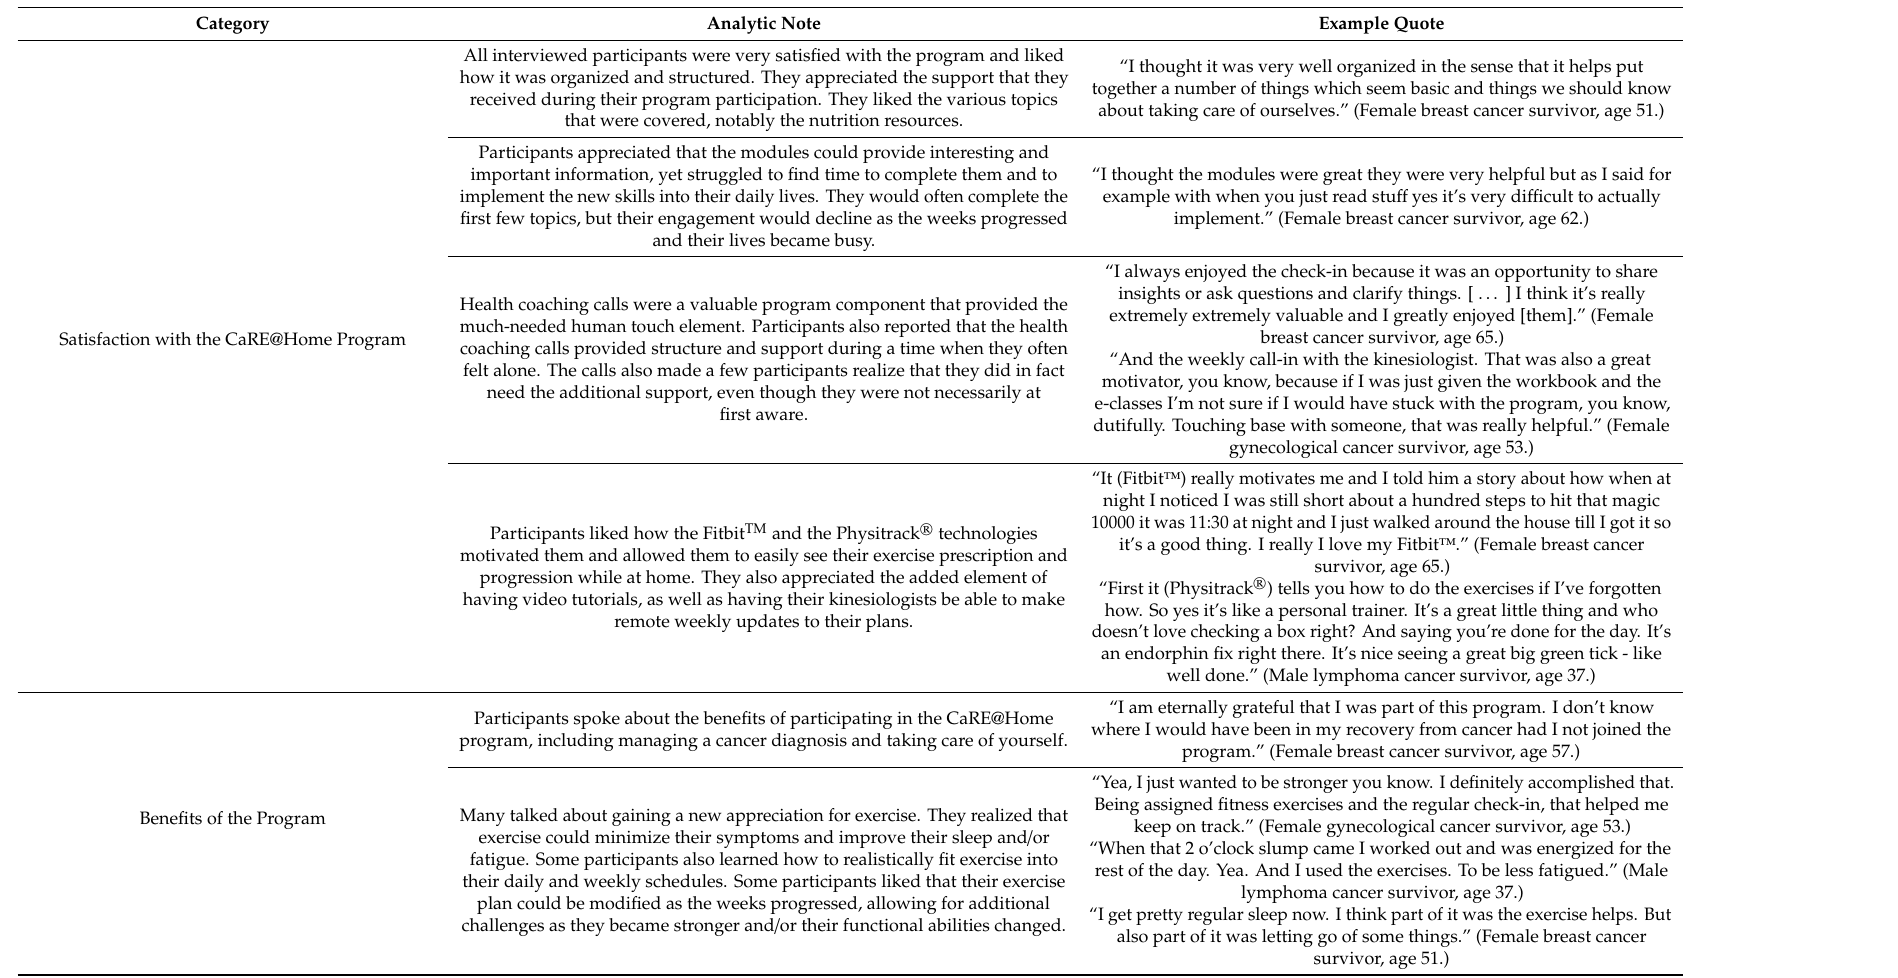
Table 4. Qualitative Table for